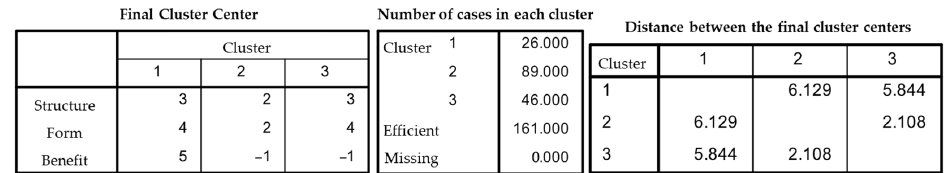
Figure A1. K ‐ means clustering analysis of historical buildings before renovation.